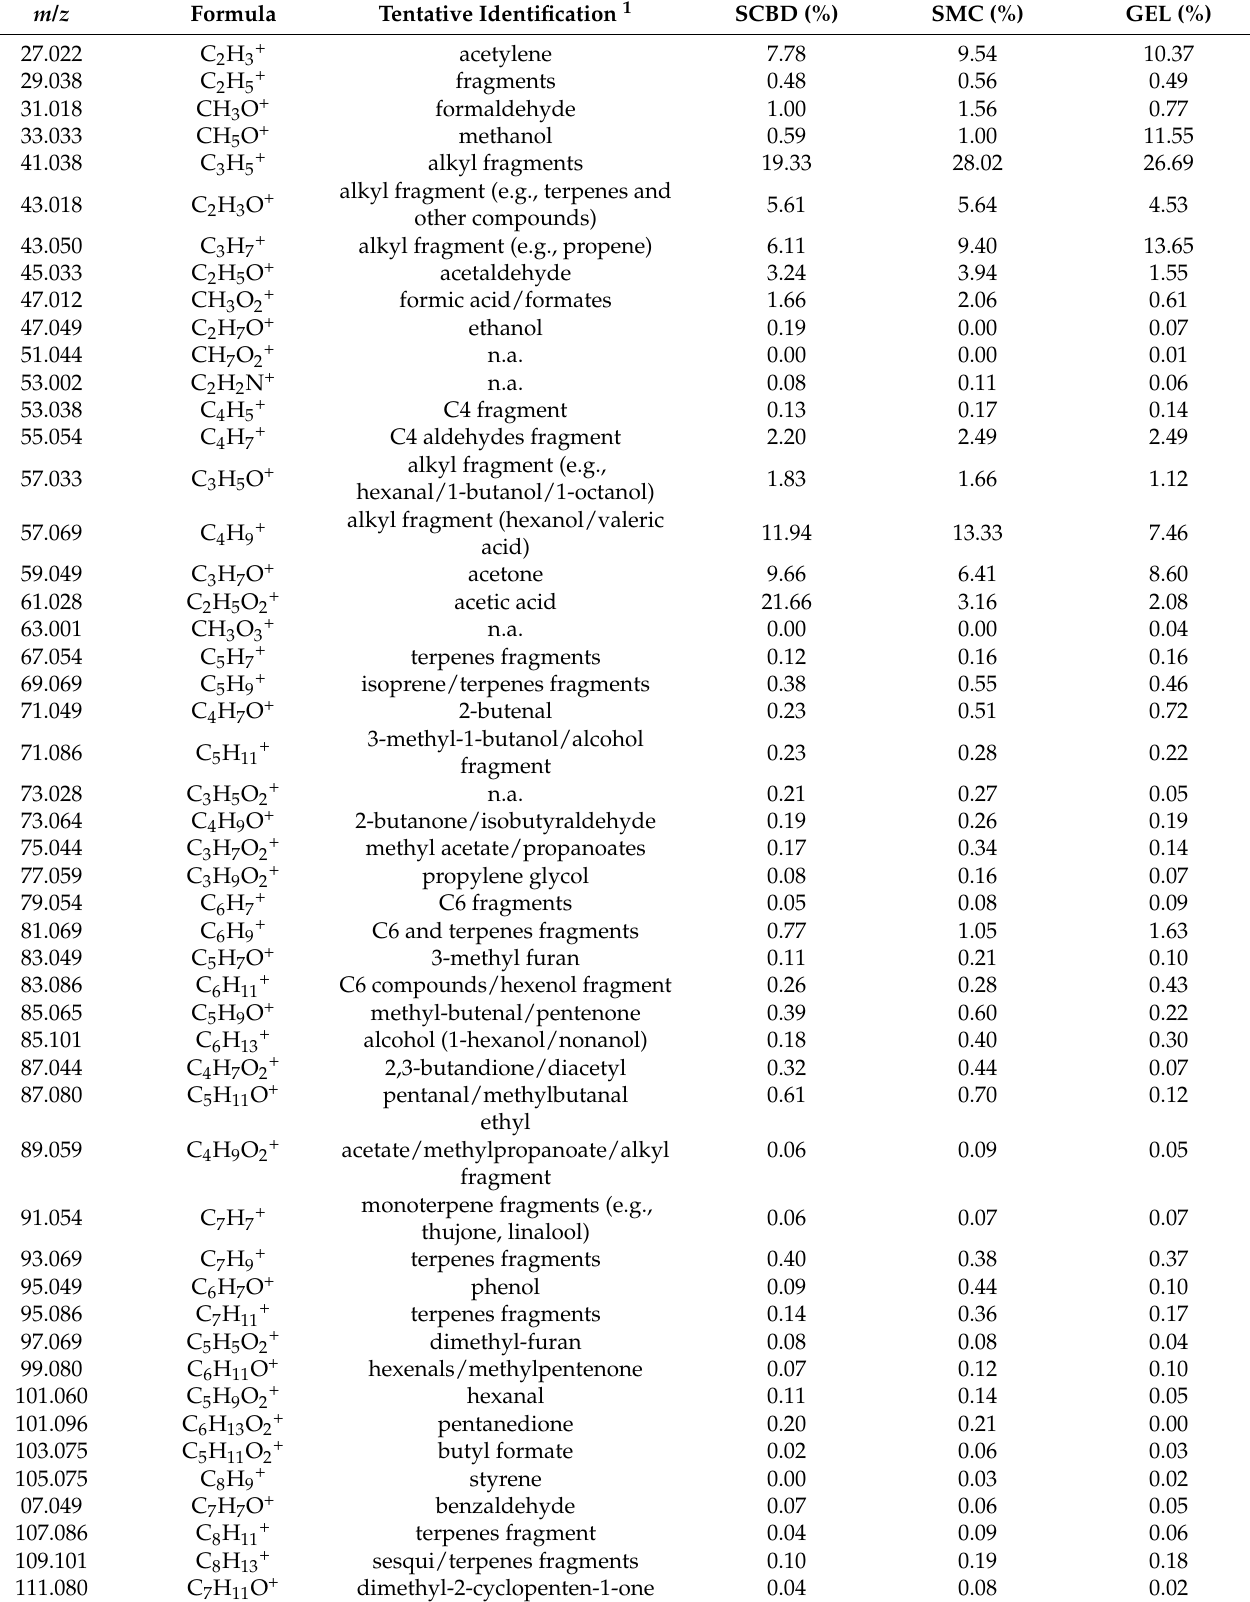
Table 4. Chemical composition (percentage emission for each m / z detected) of Cannabis sativa pollen extracts identified via PTR-ToF-MS. Data are expressed as % on the